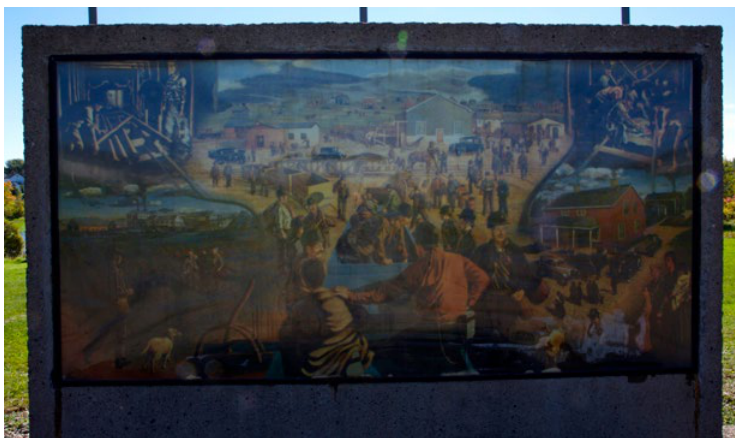
Figure 9. The Mine Fatality